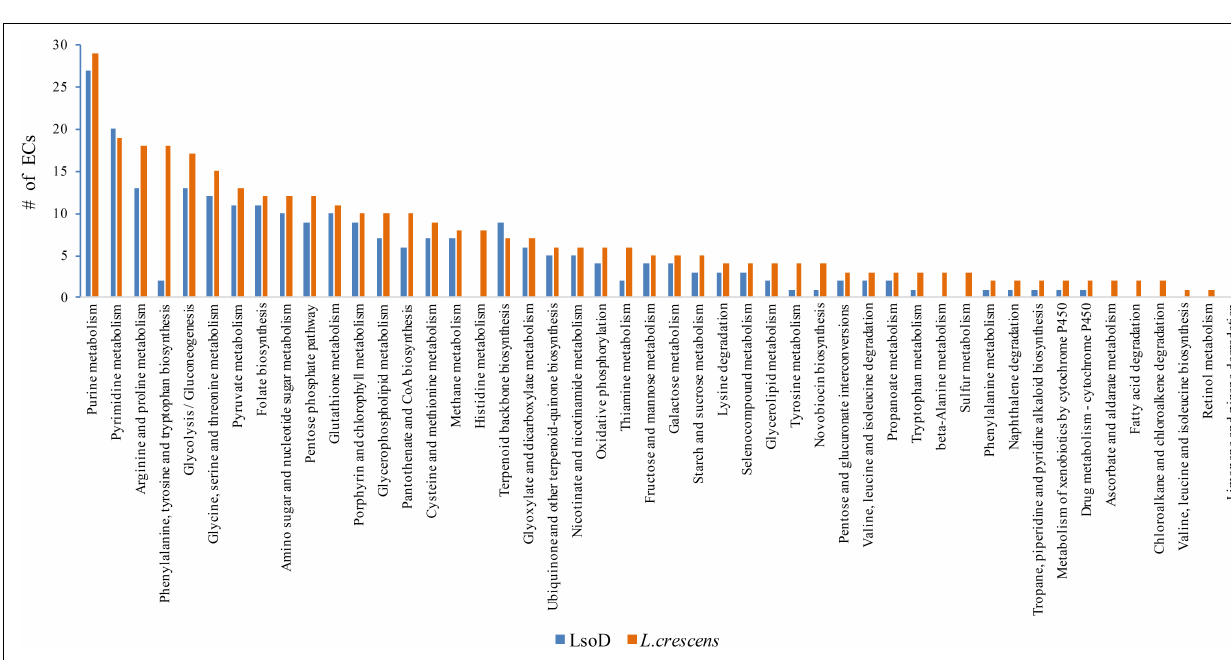
FIGURE 5 | Comparison of the number of ECs for LsoD and L. crescens is mapped to metabolic and degradative pathway. The absolute number of ECs for each pathway is graphically